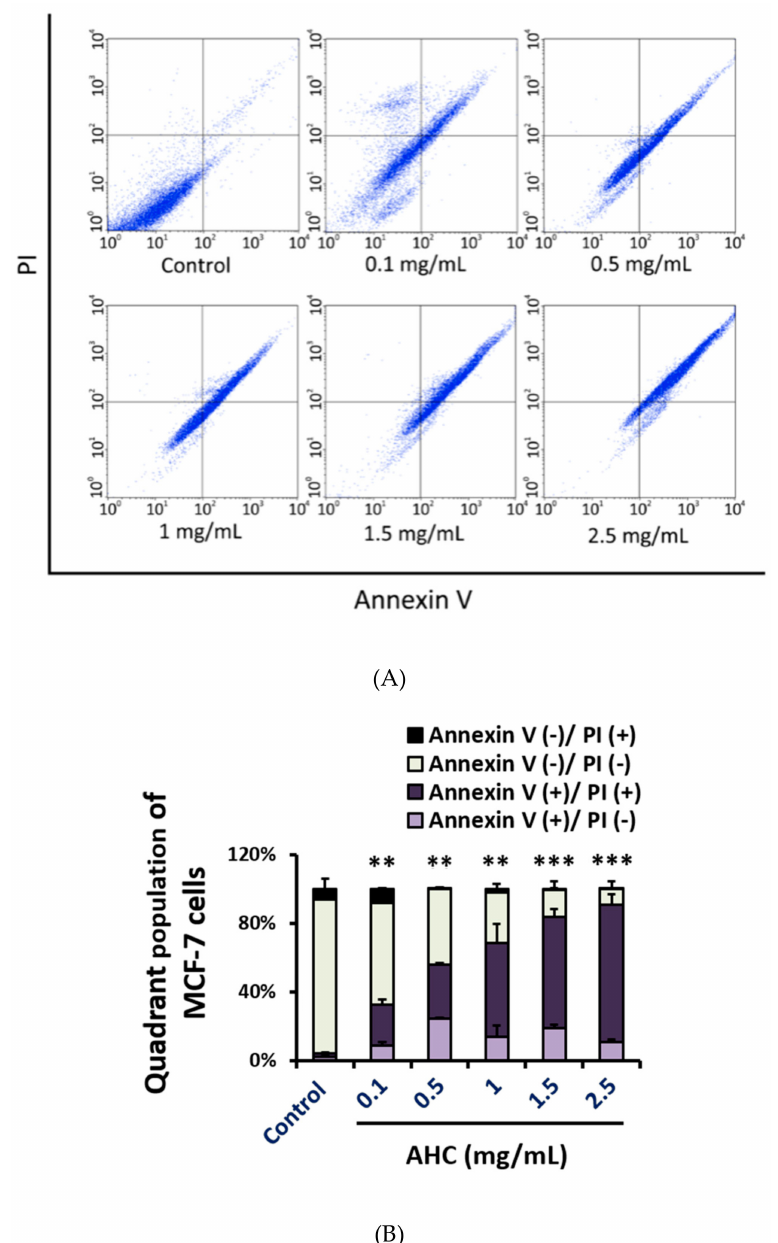
Figure 7. Apoptotic e ff ect of the AHC extract against MCF-7 cells after 24 h treatment was monitored by flow cytometry. ( A ) Quadrant populations of MCF-7 cells ( B ) Diagram of quadrant distribution of the cells. Control: 0.1% DMSO in culture medium. Data of ** p < 0.05 and *** p < 0.005 vs. late apoptotic cells of control. Propidium iodide